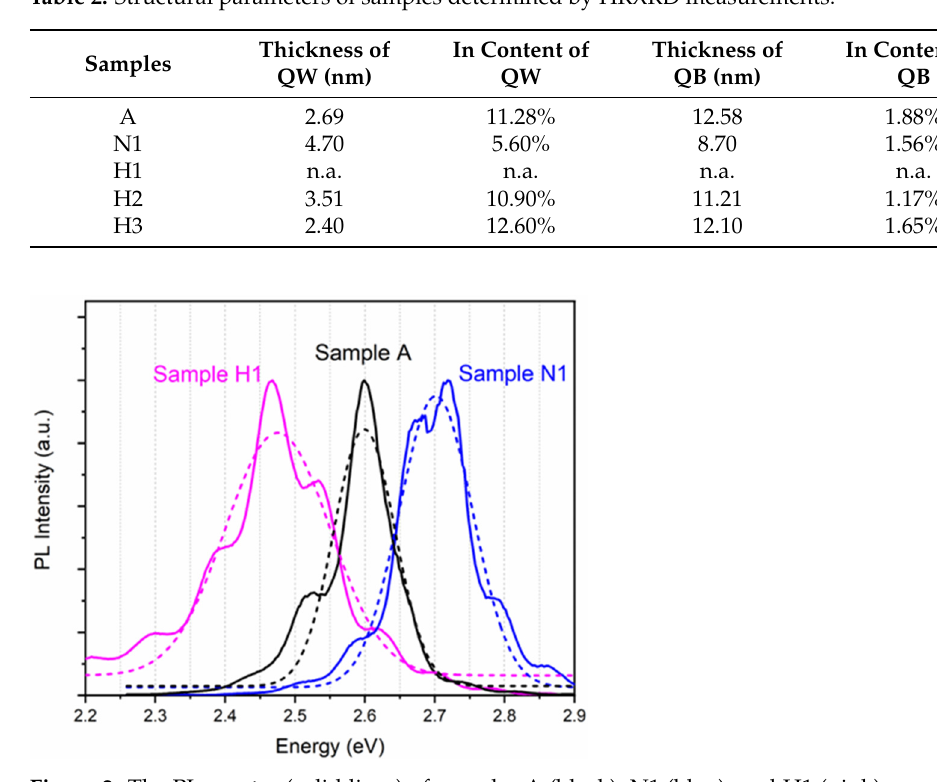
Figure 2. The PL spectra (solid lines) of samples A (black), N1 (blue), and H1 (pink) measured at 30 K. The dashed lines show the Gaussian fitting curves to the measured PL spectra for each sample. The fringes in the spectra are caused by the Fabry–Perot interference effect.